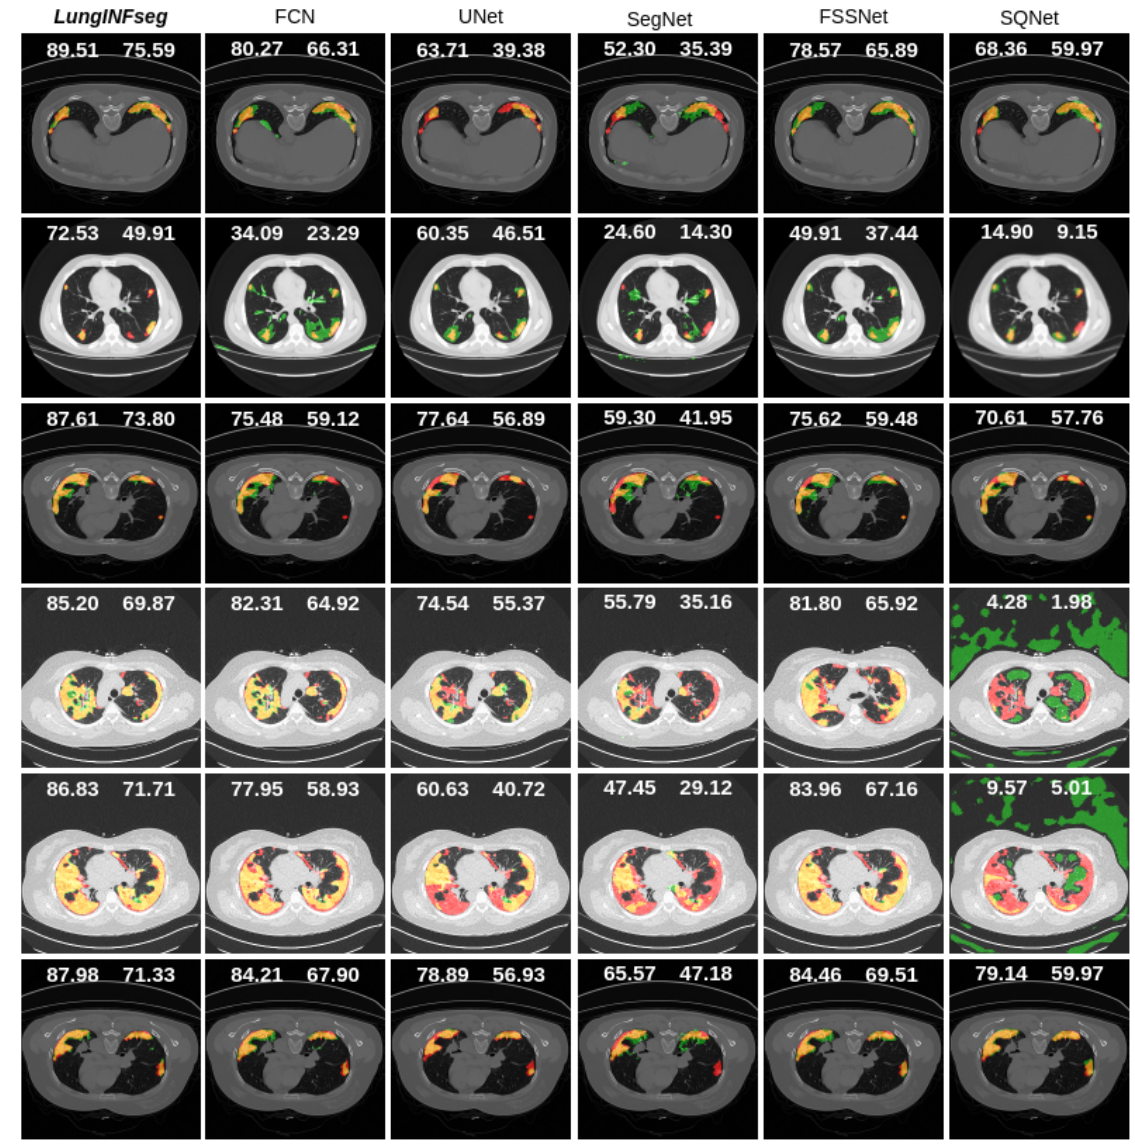
Figure 14. Qualitative comparison of the segmentation results of LungINFseg and five state-of-the-art segmentation methods (left to right: LungINFseg-SQNet). Here, left and right side numbers on each example refer to dice and IoU scores, respectively. The colors used to represent the segmentation results are as follows: TP (orange), FP (green), FN (red), and TN